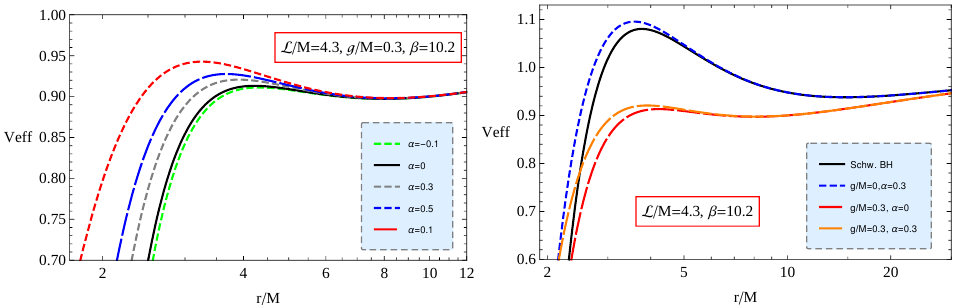
Figure 5. Radial dependence of the effective potential for radial motion of a magnetized test particle with β = 10.2 around regular BH in EDGB gravity for different values of parameter α